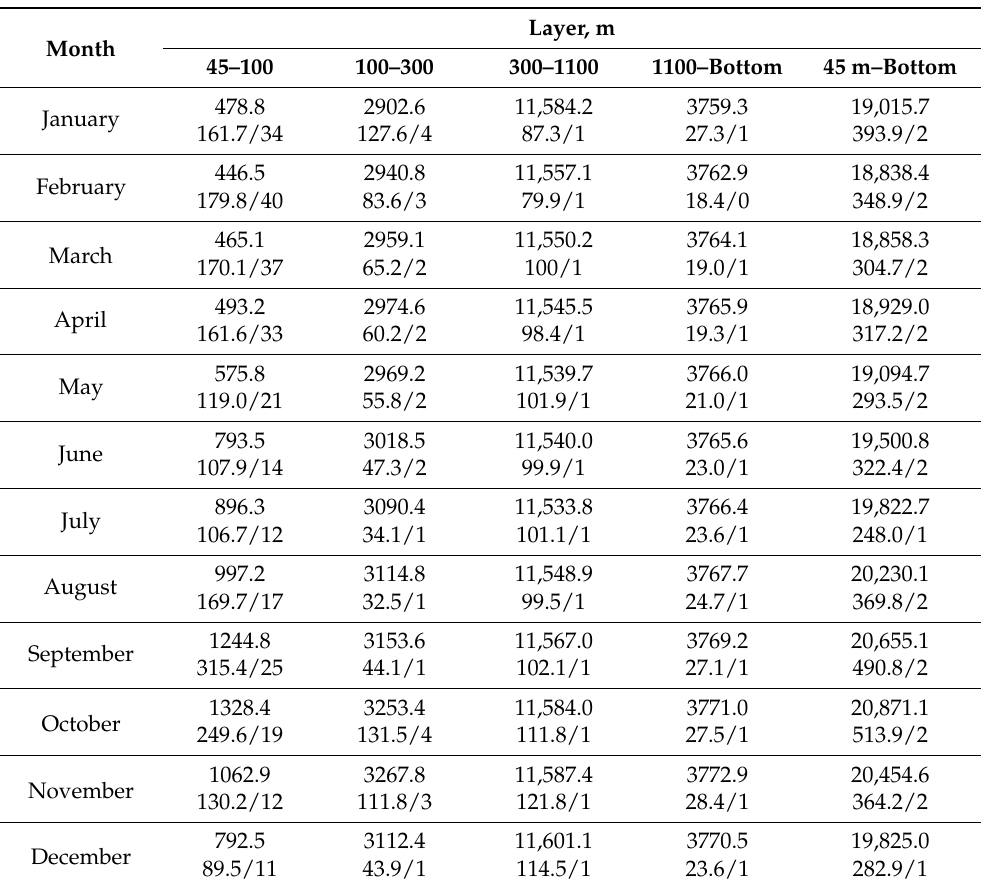
Table 1. Average values (upper value, MJ/m 2 ) and standard deviation (lower value, absolute (MJ/m 2 ) and relative (%) values) of the heat content values for certain water layers calculated based on the BS IC